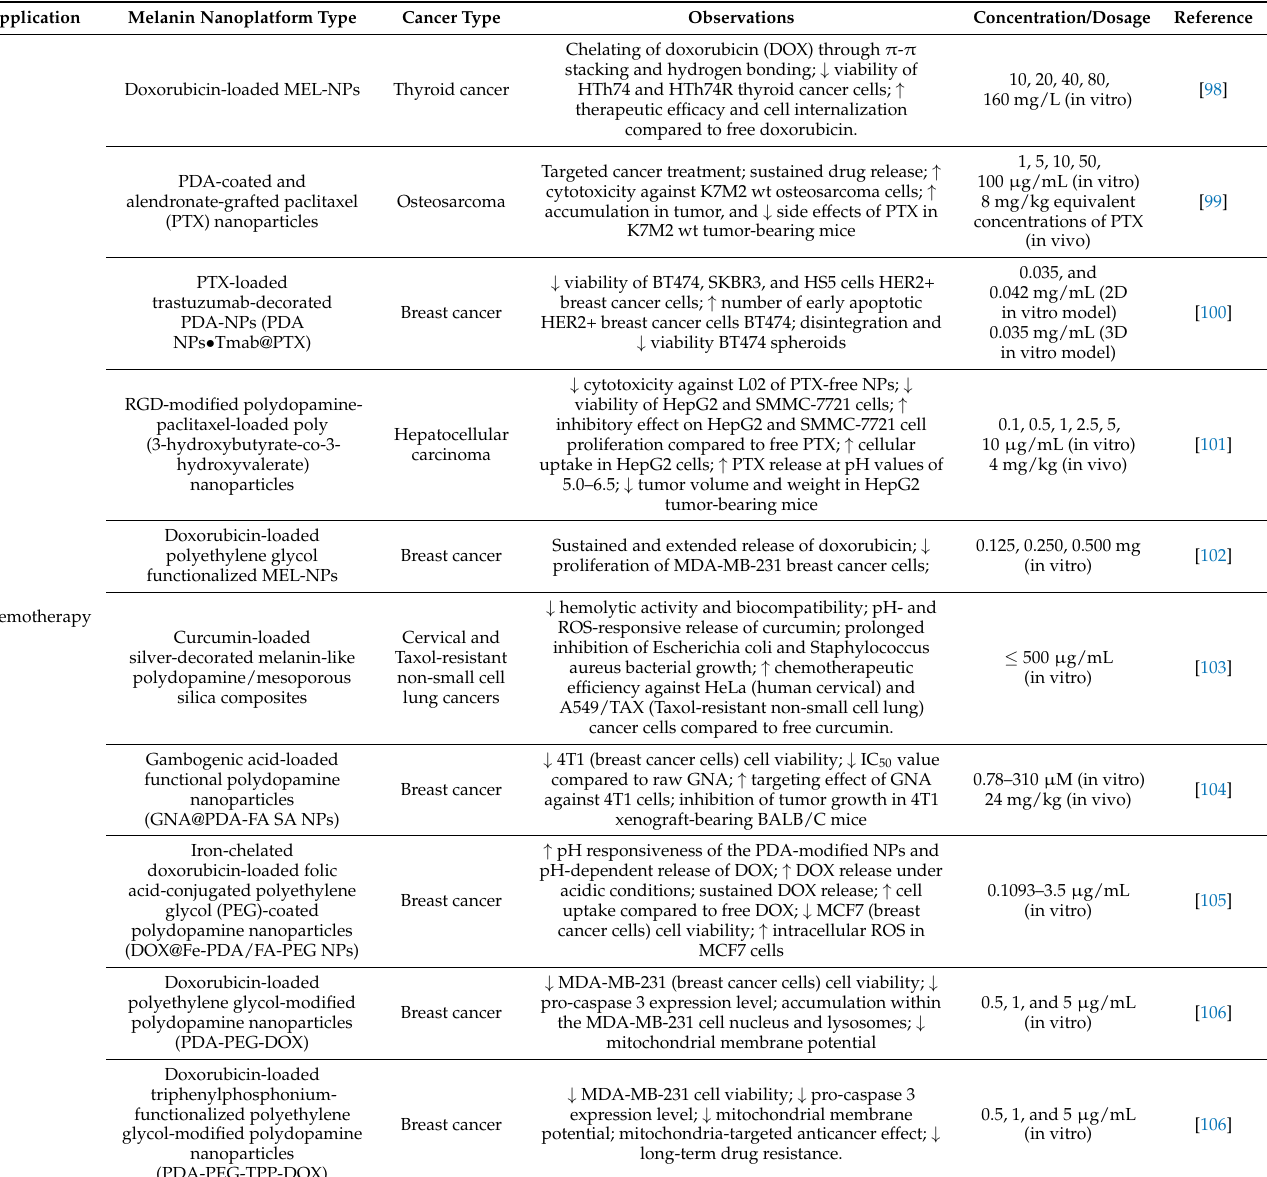
Table 2. Relevant studies highlighting the applications of melanin-based nanosystems in cancer